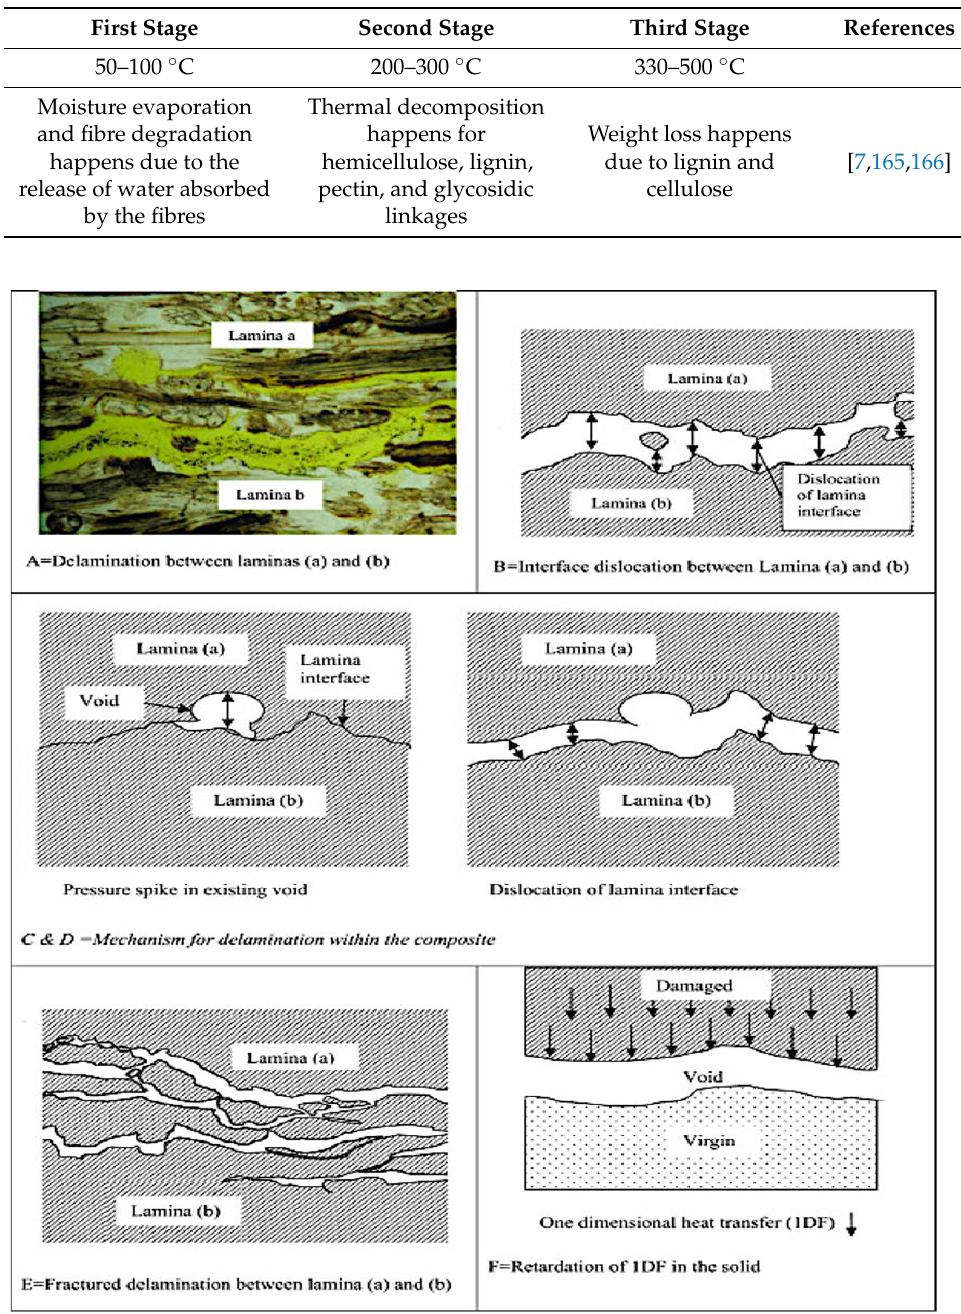
Figure 13. Delamination mechanisms observed in composite due to various environmental condi- tions [164] (reprinted with permission from Elsevier, Licence Number: